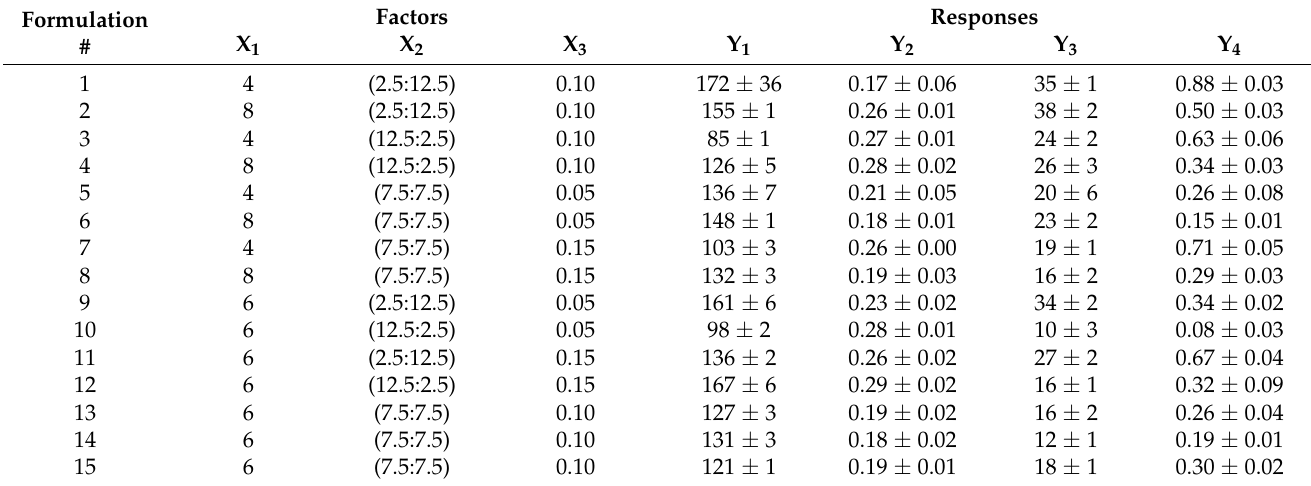
Table 2. Composition of the prepared formulations and obtained responses ( n = 3, mean ± SD) for optimizing IBU-loaded transfersomes using BBD.